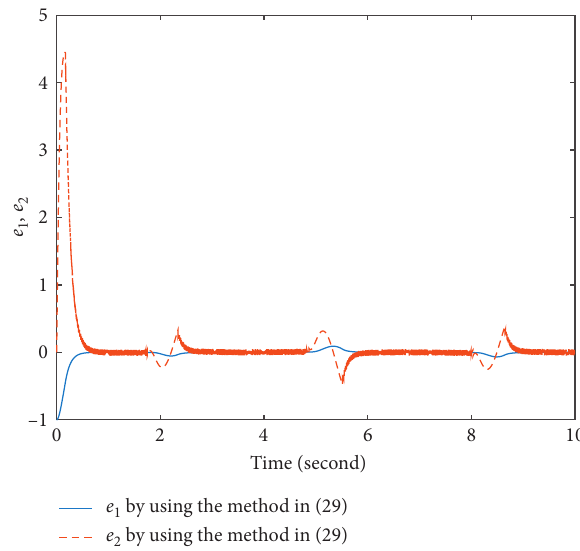
Figure 2: Trajectories of e